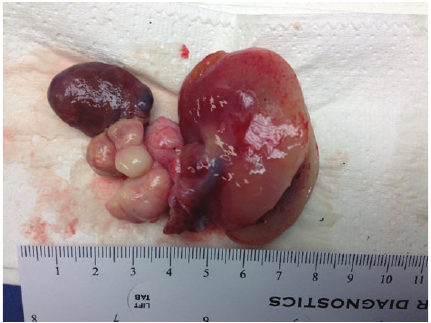
Figure 5: Large, multilobular